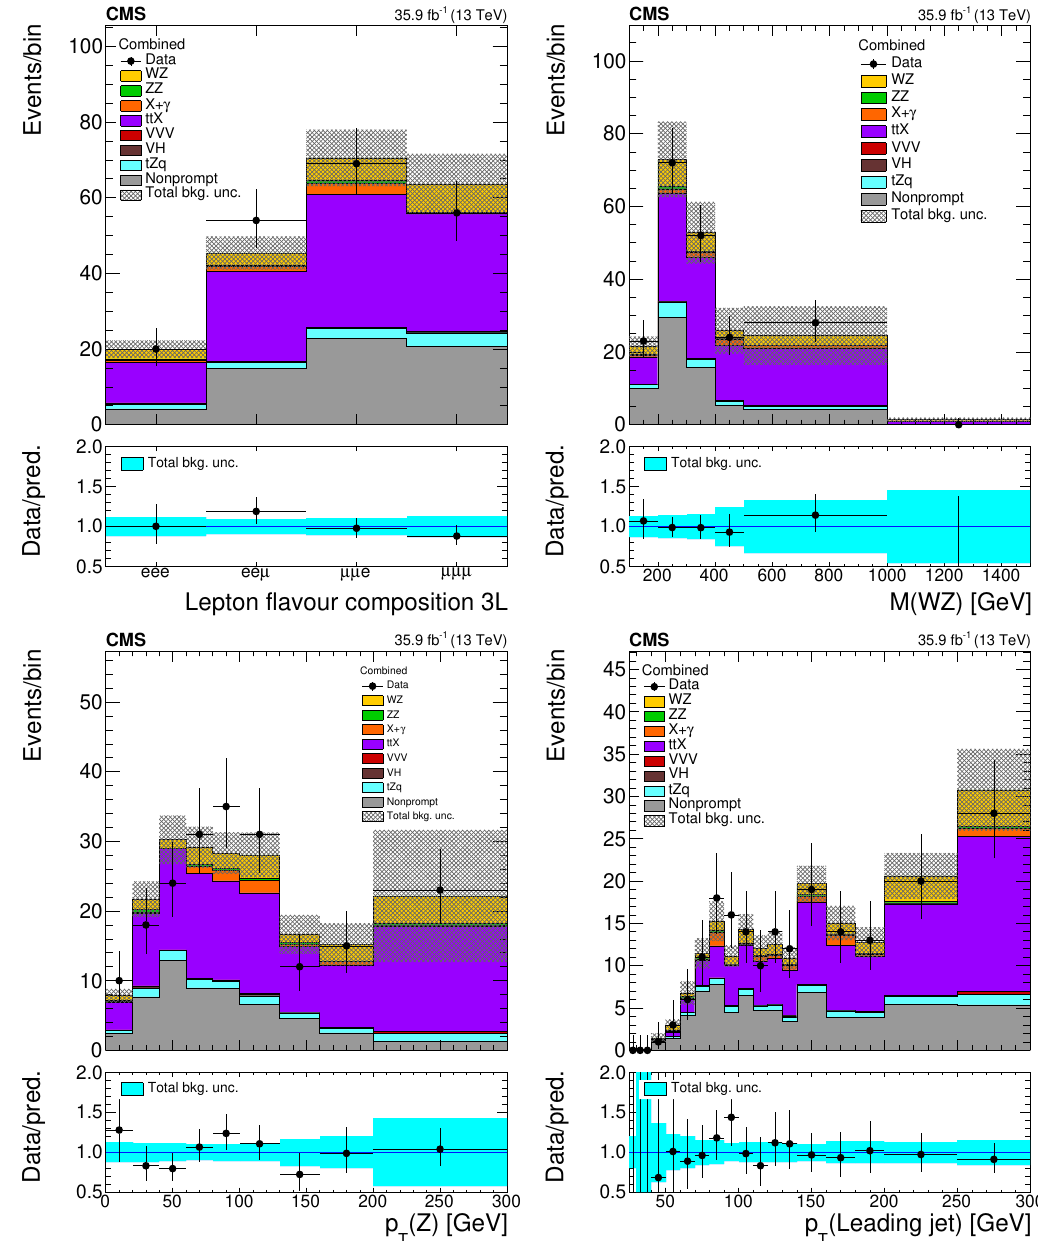
Figure 4 . Distribution of key observables in the top enriched control region de(cid:12)ned in table 1: (cid:13)avour composition of the three leading leptons (top left), invariant mass of the three lepton plus missing transverse momentum (top right), transverse momentum of the Z boson reconstructed from the p T of the two leptons assigned to it (bottom left), and transverse momentum of the leading jet (bottom right). Vertical bars on the data points include the statistical uncertainty and shaded bands over the prediction include the contributions of the di(cid:11)erent sources of uncertainty evaluated after the signal extraction